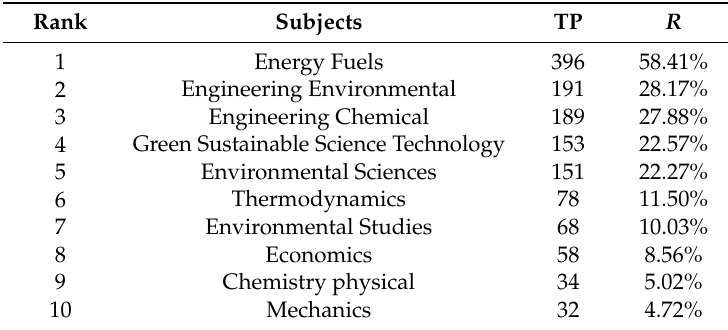
Table 1. The 10 most productive subjects.